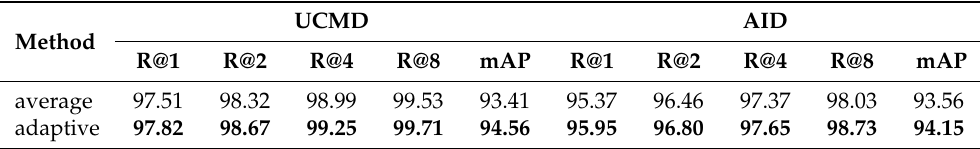
Table 6. Validation of the proxy weighting method on UCMD and AID. The best results are shown in